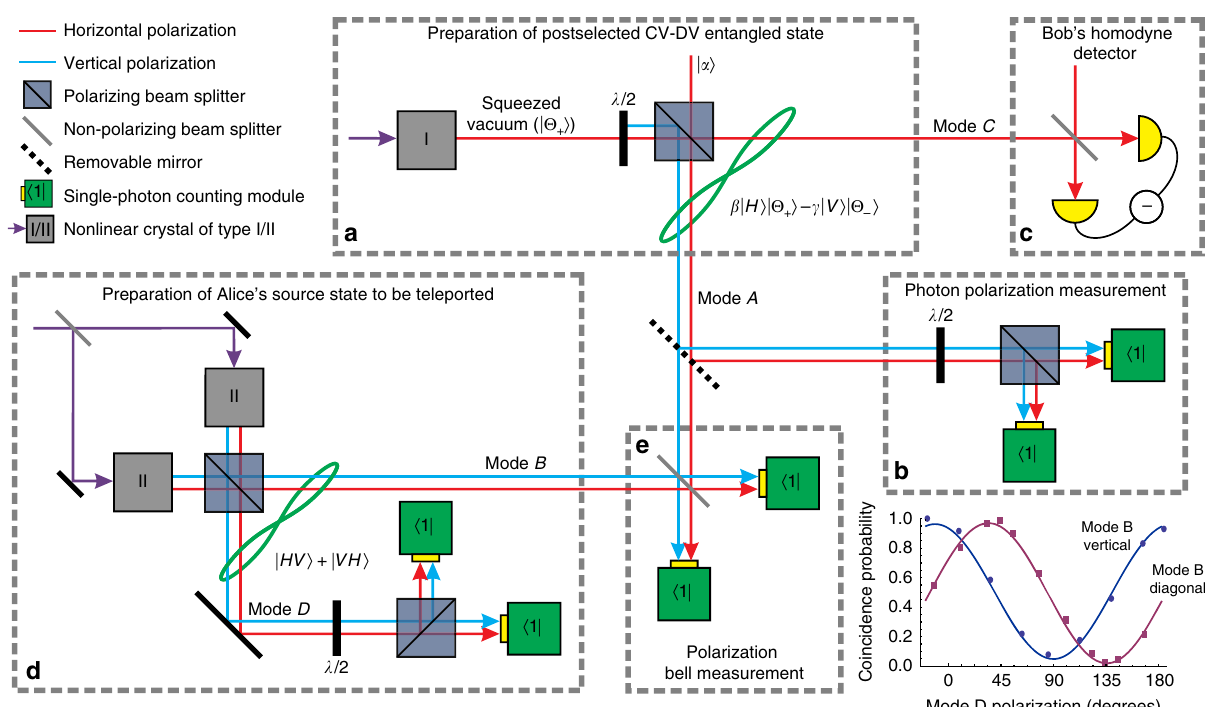
Fig. 1 Conceptual scheme of the experiment. a State Eq. (3) is prepared in modes A and C. This state is equivalent to the discrete-continuous entangled state Eq. (1) conditioned on the presence of a photon in mode A. If the photon in mode A comes from Θ becomes Θ . If the photon comes from the horizontally polarized state α j i , the state in mode C remains Θ (cid:2) j i the polarization of the photon in the discrete mode ( b ) and performing homodyne tomography ( c ) of the state in the continuous mode. d Preparation of the heralded photon in mode B whose polarization is used as the source state for teleportation. e Polarization Bell measurement teleports that state onto mode C. The mirror leading to part b is removed for the teleportation experiment. The inset shows the coincidence rate for simultaneous polarization measurements in modes B and D as a function of the polarization projection angle in mode D while a polarizer is set in mode B to project it onto either horizontal or